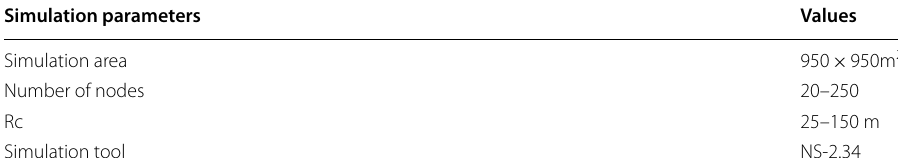
Table 2 Simulation parameters